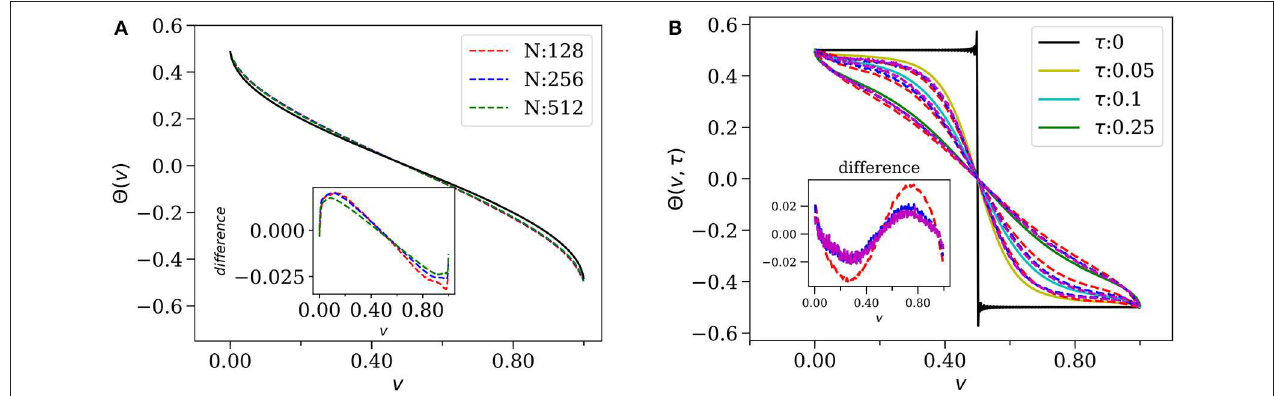
FIGURE 12 | (A) Comparison of temperature profiles obtained theoretically from Equation (83) (solid black line) with the same obtained from direct numerical simulations of microscopic system for N 128,256,512. The agreement between theory and numerics becomes better for larger N as can be seen in the inset where = the difference between theoretical curve (Equation 83) and simulation data are plotted for various system sizes. (B) Time evolution of temperature starting from an T ] /1 T , with T ( v , τ ) given by Equation (93), is plotted and compared with direct numerical simulations. The dashed initial step profile. The function 2 ( v , τ ) [ T ( v , τ ) = − ¯ lines indicate simulation results for the time-evolution in HCME at different scaled times ( τ ), for system sizes N 128 (red), N 256 (blue), N 512 (magenta), while = = = the solid lines are obtained from the theory. The boundary temperatures were fixed at T ℓ 1.5 and T r 0.5 (adapted from Kundu et al. with permission from [37] = = Copyright SISSA Medialab Srl, IOP